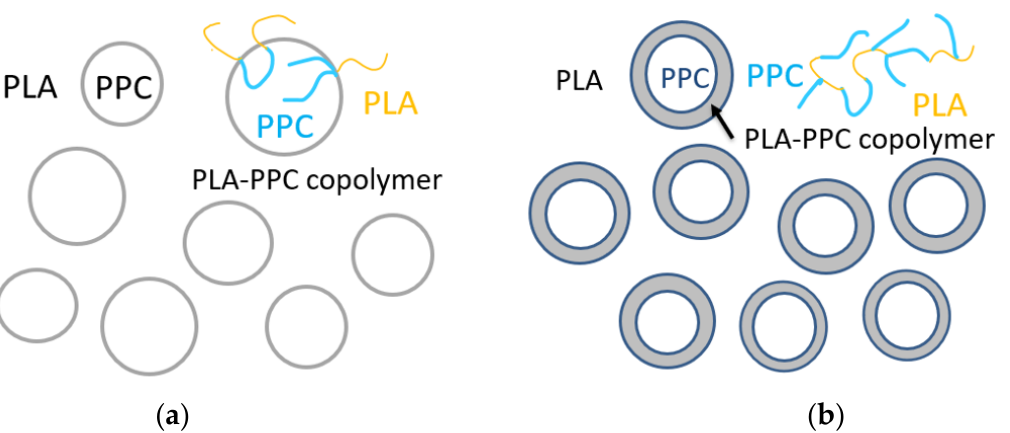
Figure 4. Schematic drawing of a small fraction of PLA-PPC block copolymer, obtained by the transesterification initiated with added TBT, act as the compatibilizer at the interface between PLA and PPC phases in PLA70/PPC30 blend with 1–2% of TBT ( a ), and the interphase between PLA and PPC phases, made of significant amount of PLA-PPC copolymer in PLA70/PPC30 blend with 2% of TDI due to the reaction of chain extension initiated by TDI ( b ).